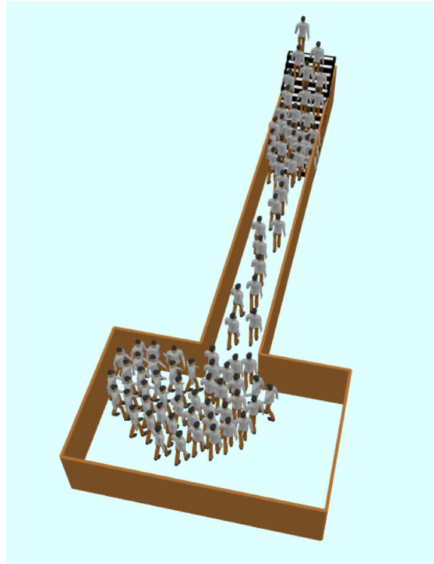
Figure A10. The scenario of test 10.